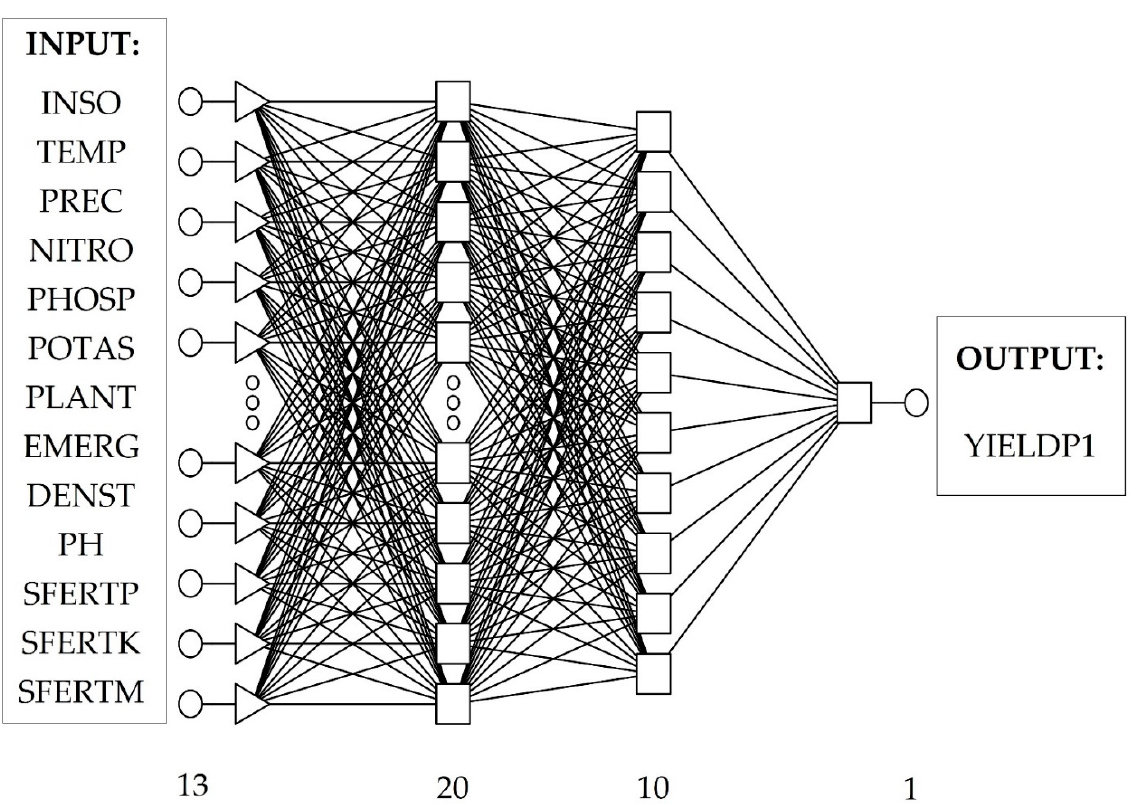
Figure 3. Diagram of MLP 13:13-20-10-1:1 neural network creating the NY1 model with an indication of the number of neurons at the input and output of the network and with two hidden layers.